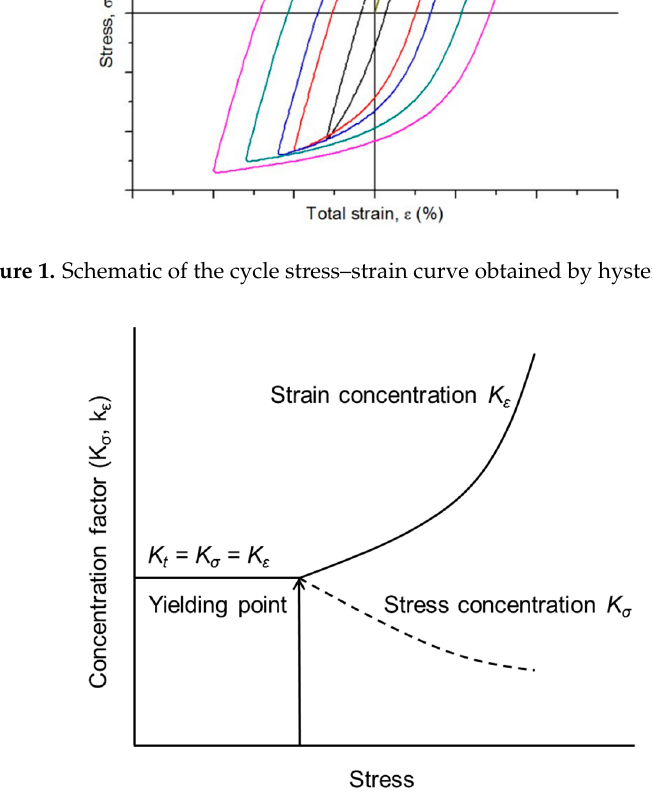
Figure 2. Effect of stress concentration and strain concentration after localized yielding.